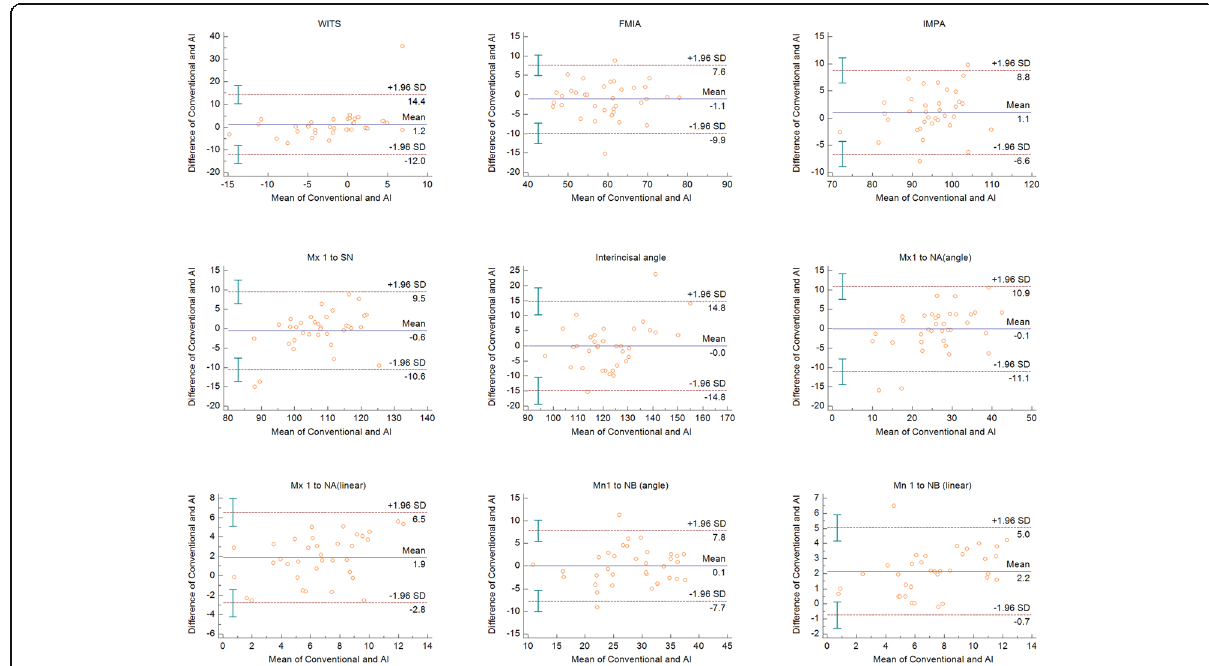
Fig. 3 Bland-Altman plots for the dental measurements in each conventional and AI methods